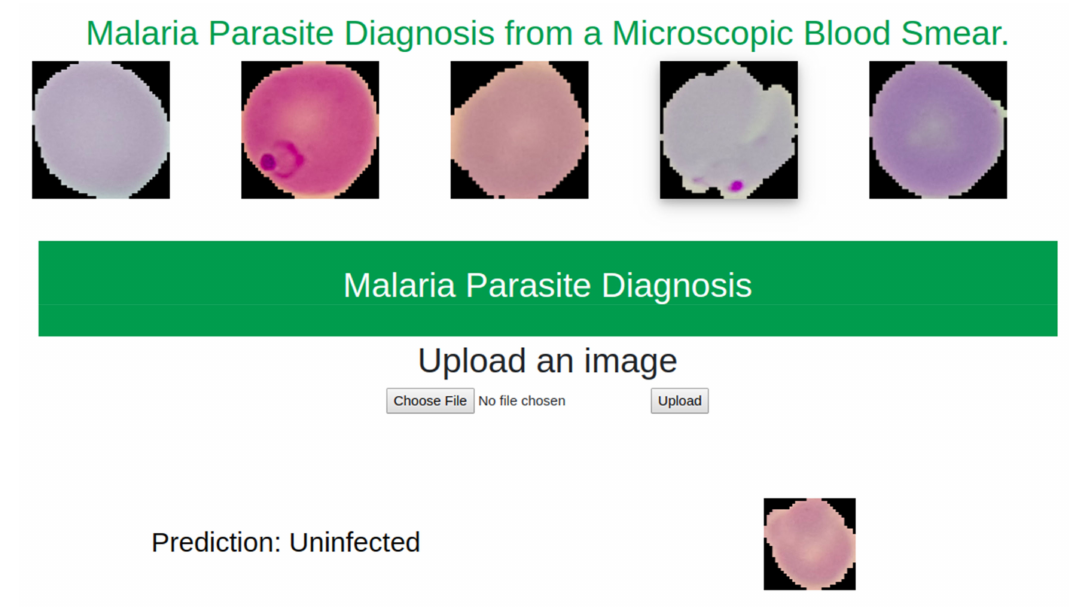
Figure 16. Model behavior on web based